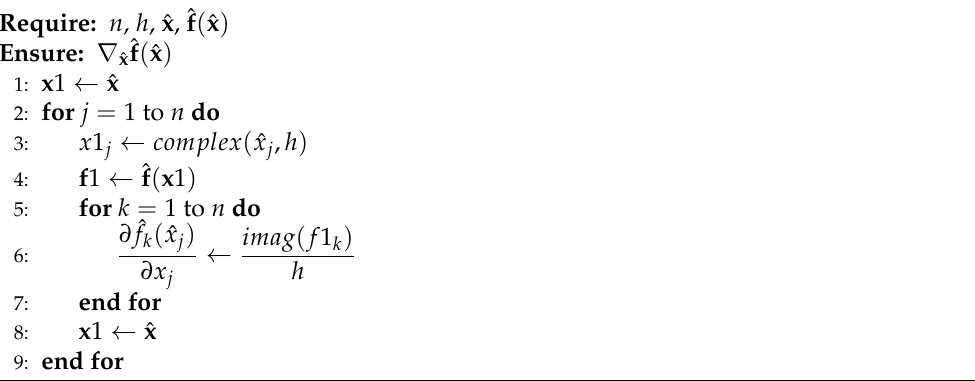
Algorithm 4 Calculation of derivatives at the i -th time point using the complex-step